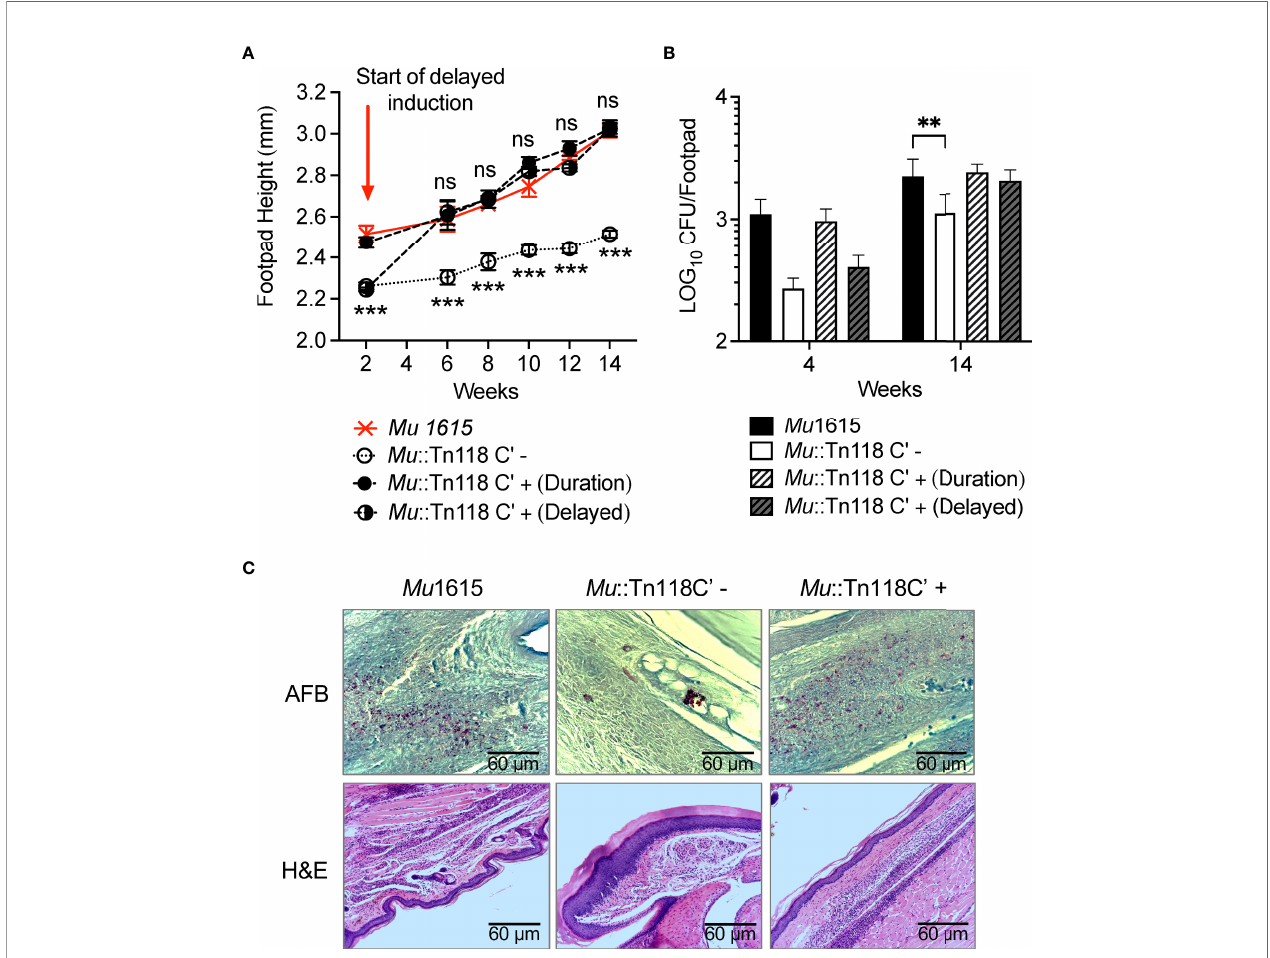
FIGURE 6 | Induced synthesis of mycolactone restores Mu ::Tn118 function in a murine model of BU. (A) Footpad heights of C57Bl/6J mice infected with 1 × 10 4 bacteria of Mu 1615 or Mu::Tn118C ’ ± doxycycline in left hind footpads. Mean ± SEM of two independent experiments (n = 8 mice). (B) Bacterial burden of infected left hind footpads of infected mice 4 and 14 weeks postinfection. Mean ± SD of two independent experiments (n = 8 mice). Signi fi cance was calculated by two-way ANOVA corrected by Dunnett ’ s test for multiple comparisons. NS, not signi fi cant. **p ≤ 0.01, *** ≤ p 0.001. (C) Representative H&E- and AFB-stained footpad sections are shown for mice at 14 weeks